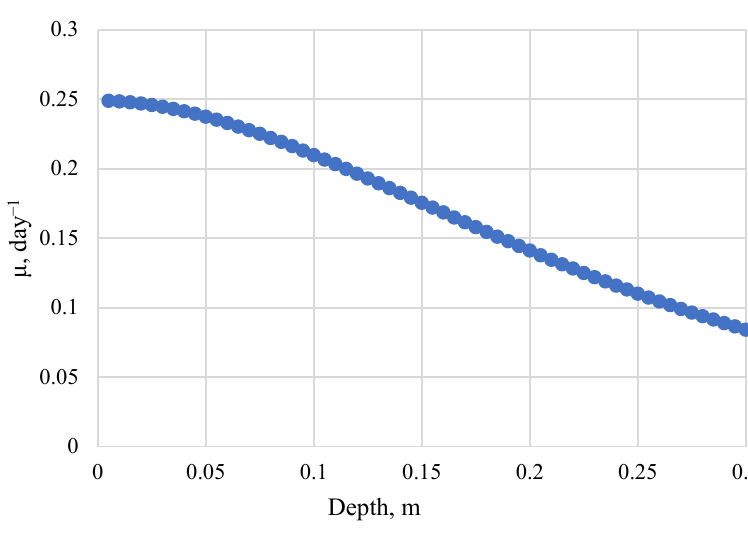
Fig. 5. Light-limitation effects according to Beer-Lambert’s Law [27].